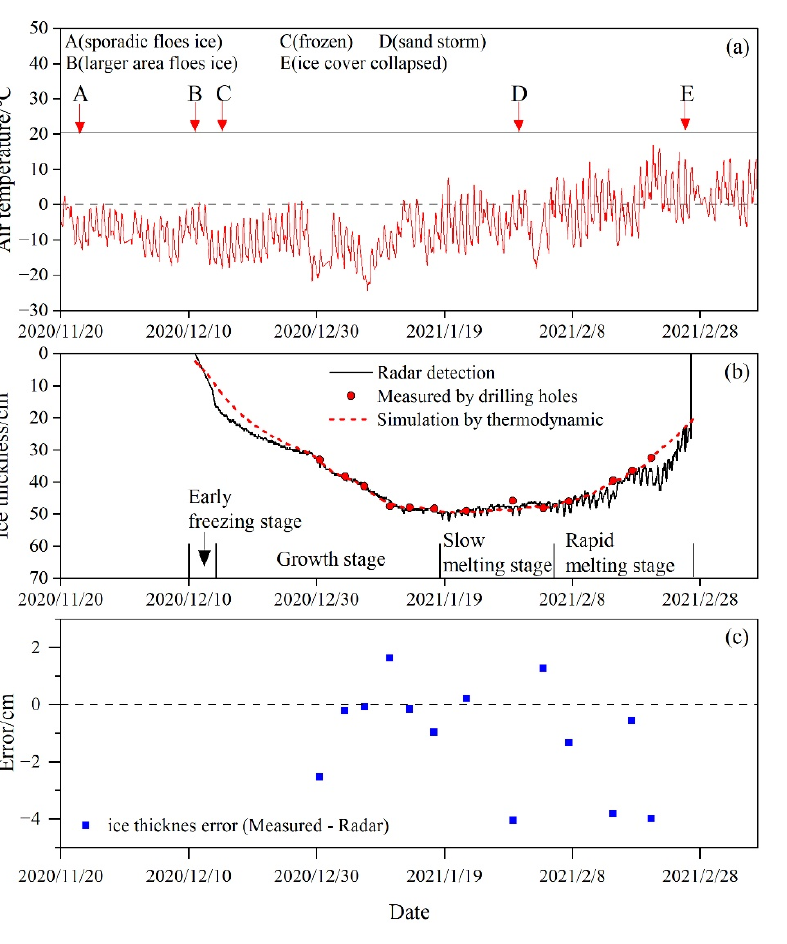
Figure 4. ( a ) Air temperature; ( b ) ice thickness via radar detection, manual measurements, and thermodynamic simulation at Shisifenzi bend in the Yellow River during 2020–2021; and ( c ) ice thickness error (between measurements and radar detection). In ( c ), positive values indicate a larger value for measurements.